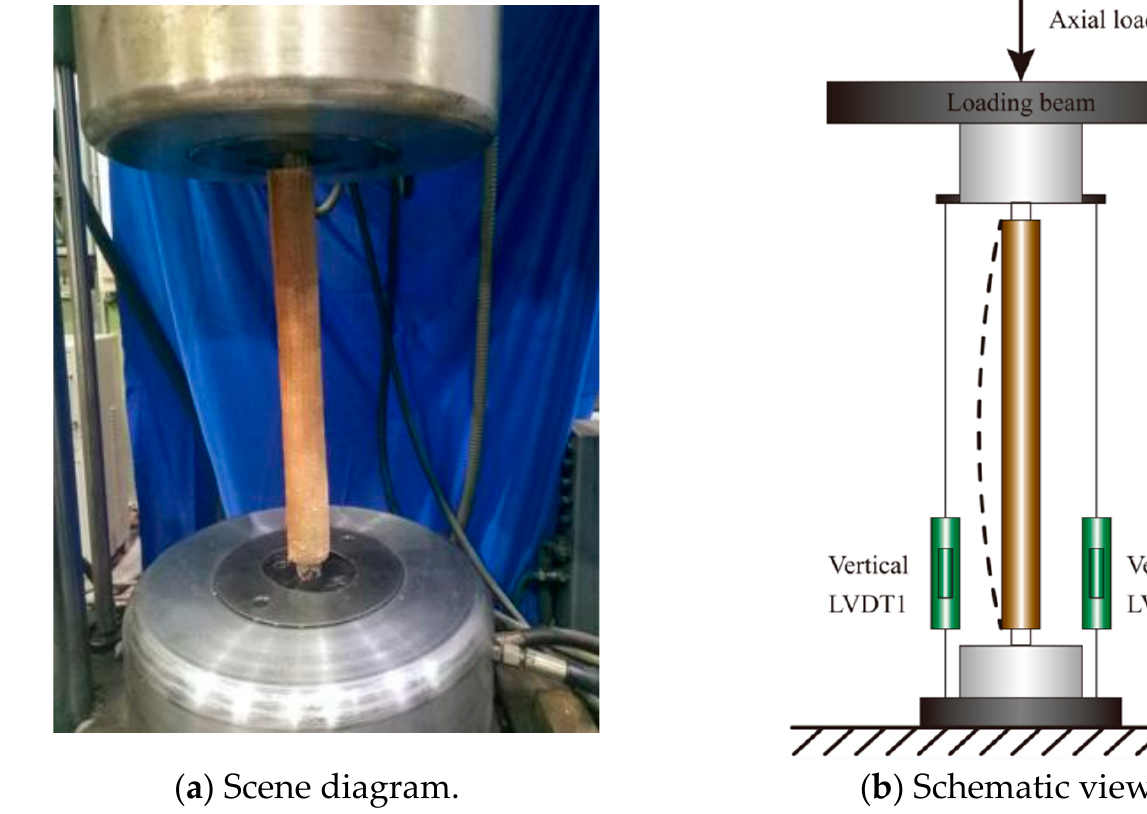
Figure 3. Test setup of FCCC-R specimen.